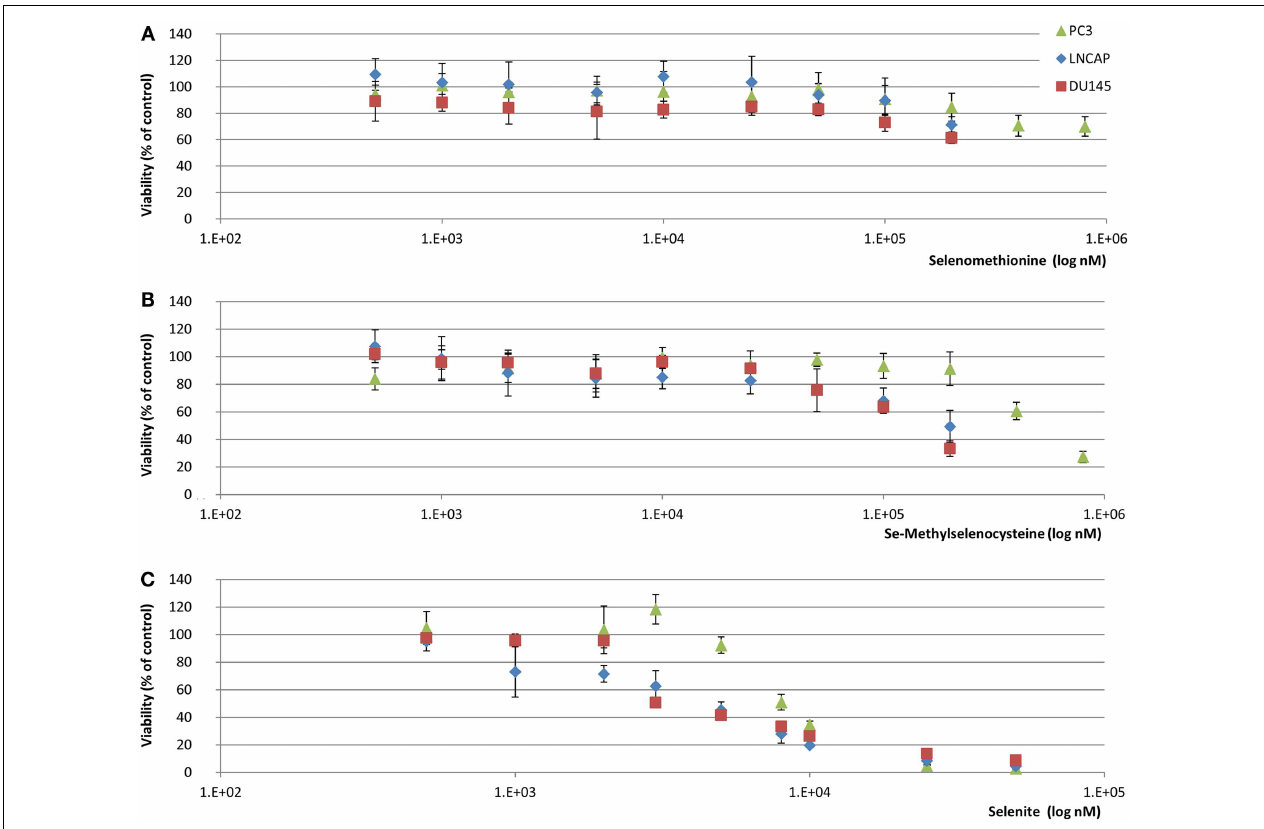
rate of untreated controls (38nM total selenium from FBS). (A) SeMet (B) SeMSC (C) Selenite. Data represents average of six biological replicates; error bars represent ±